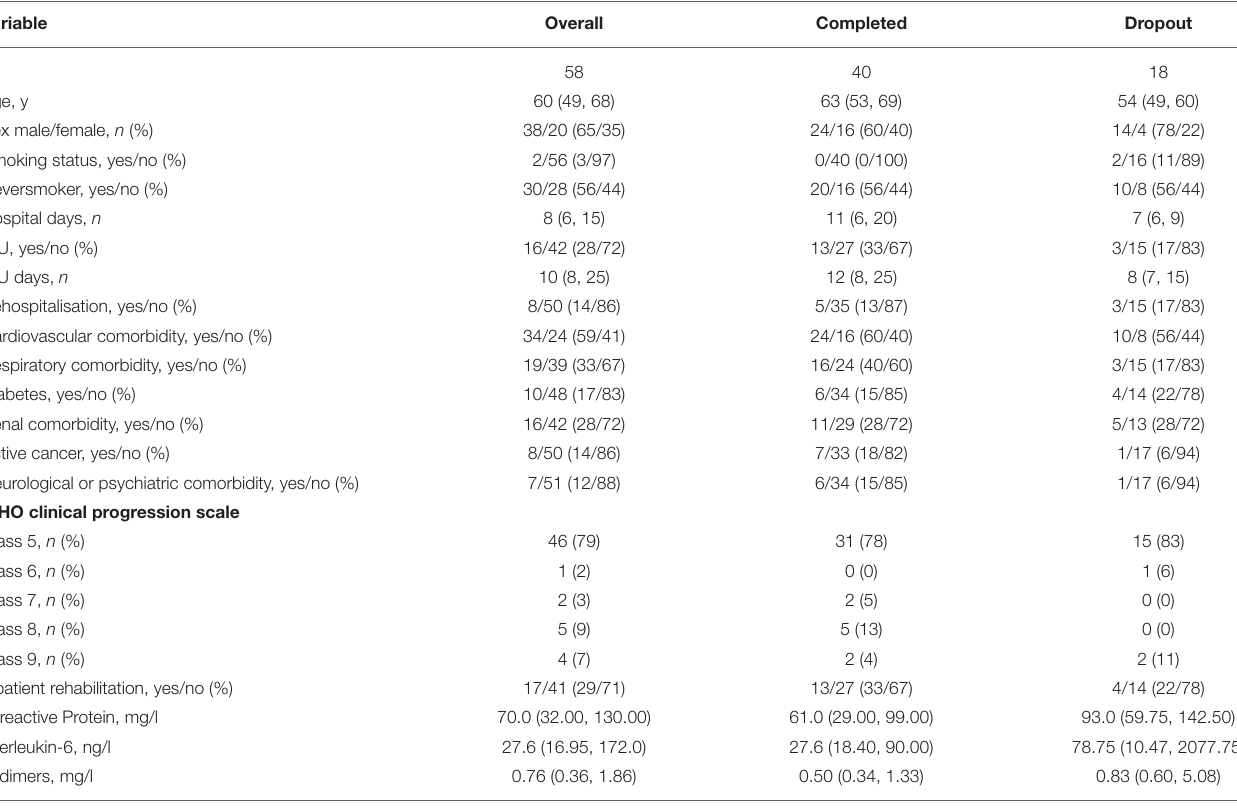
TABLE 2 | Participant characteristics stratified according to study completion status.